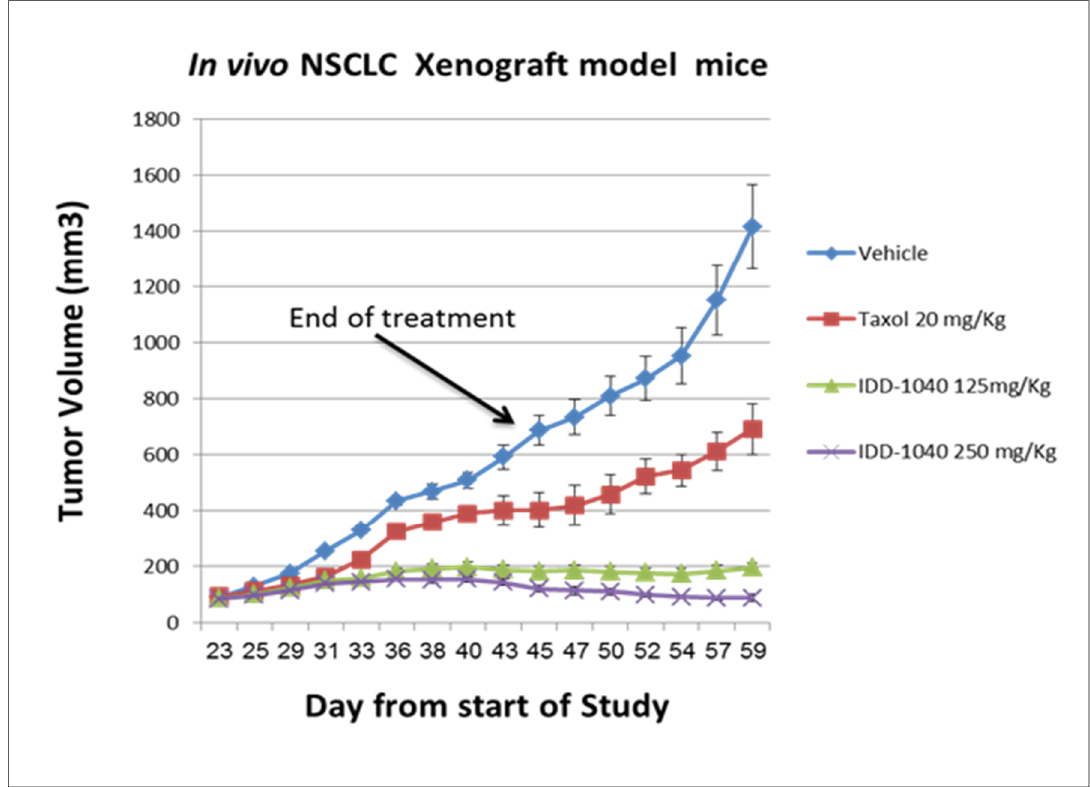
Figure 4. The effect of IDD-1040 on tumor volume in an in vivo non-small-cell, lung cancer (NSCLC) xenograft mouse model. The tumor size in all mice treated was measured every other day, starting three weeks after cell transplantation, and when tumor size reached about 100 mm 3 . The IV administration of vehicle, Taxol (paclitaxel) 20 mg / kg, IDD-1040 125 mg / kg, and IDD-1040 250 mg / kg was performed weekly for four weeks (on days 23, 30, 37, and 44). The administration of drug or vehicle was via IV bolus injection over one minute.